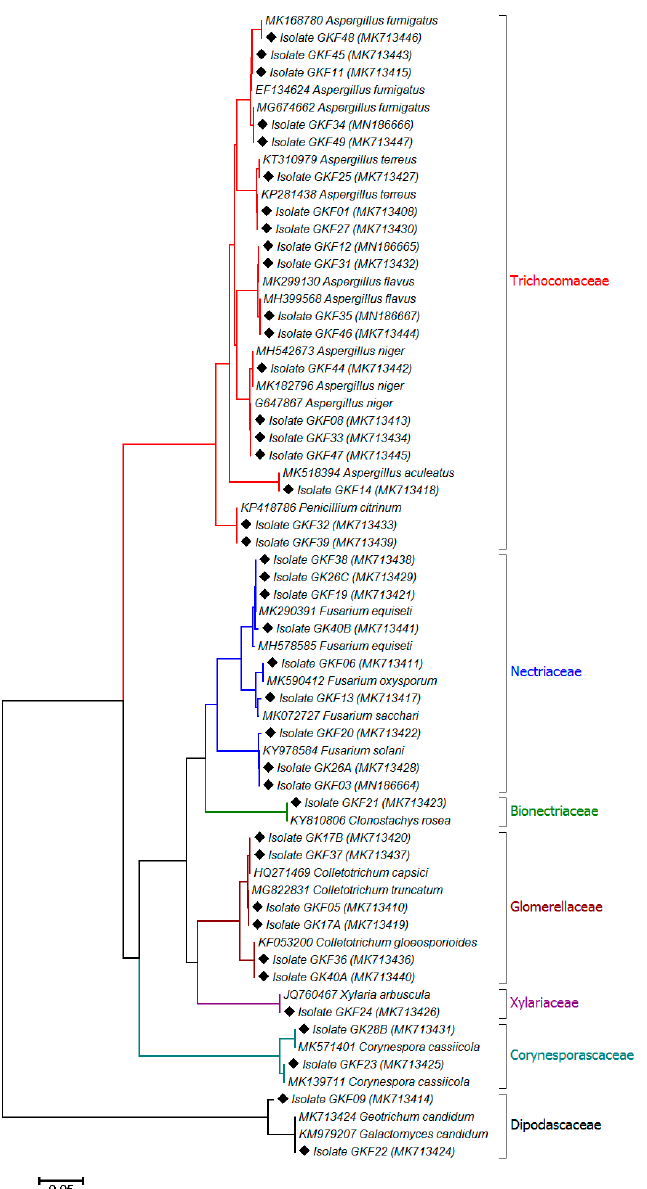
Figure 1. Phylogenetic analysis of ITS gene sequences of fungal pathogens isolated from Capsicum pepper. The fungal strains analyzed in the current study are shown by a diamond with their isolate code and accession number in parentheses. Sequences derived from the database are shown with their accession number and organism name. The tree was constructed using a Kimura 2-parameter distance with the neighbor-joining method. Bootstrap values (1000 time repeats) are used and the scale bar indicates 5 changes per 100 nucleotide positions. All positions containing gaps and missing data were eliminated.